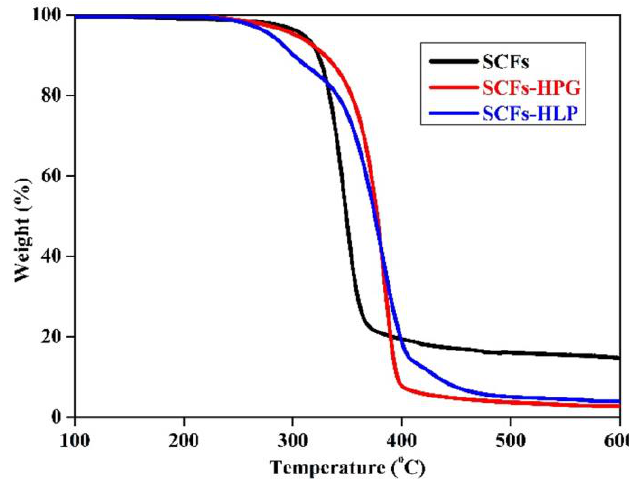
Figure 2. Thermogravimetric analysis (TGA) thermograms of SCFs, SCFs-HPG, and SCFs-HLP.